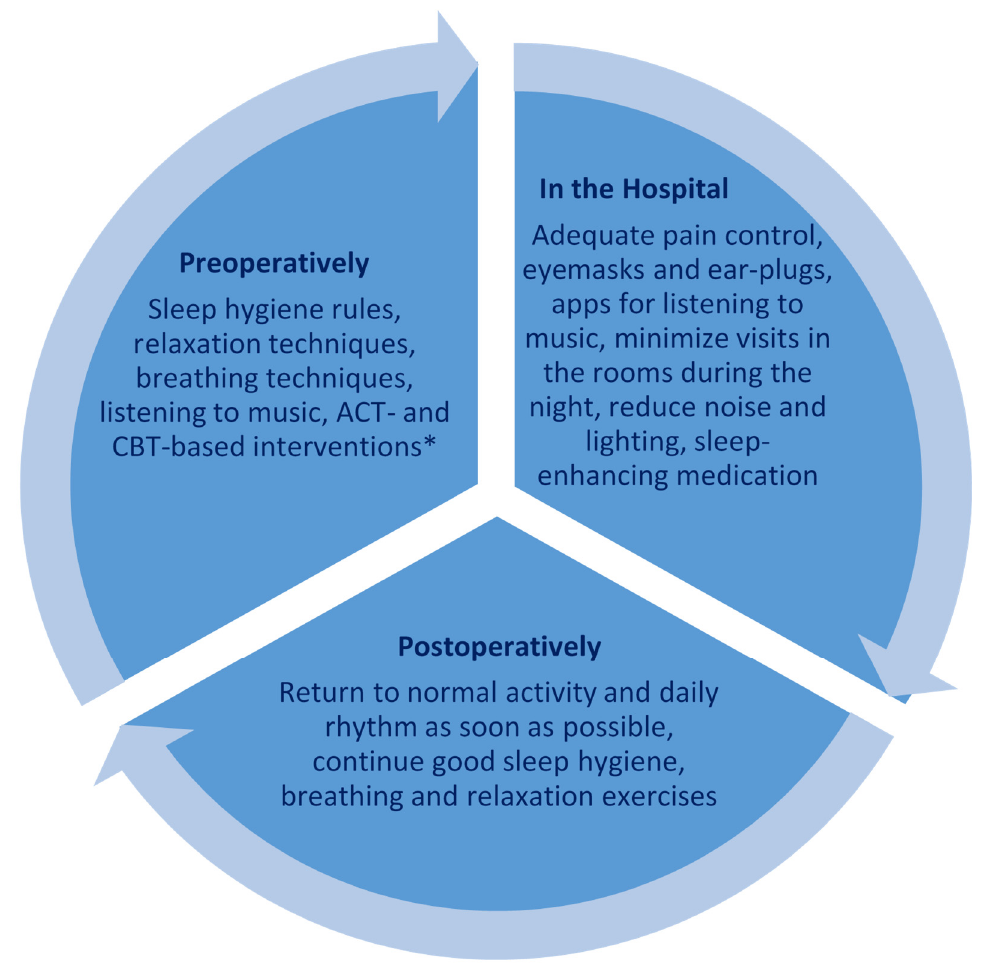
Figure 2. How to improve sleep quality pre- and postoperatively. Non-pharmacological interventions to support sleep preoperatively should be continued postoperatively. Abbreviations: CBT = Cognitive Behavioral Therapy; ACT = Acceptance and Commitment Therapy. * Need to be initiated about 6–8 weeks before surgery.